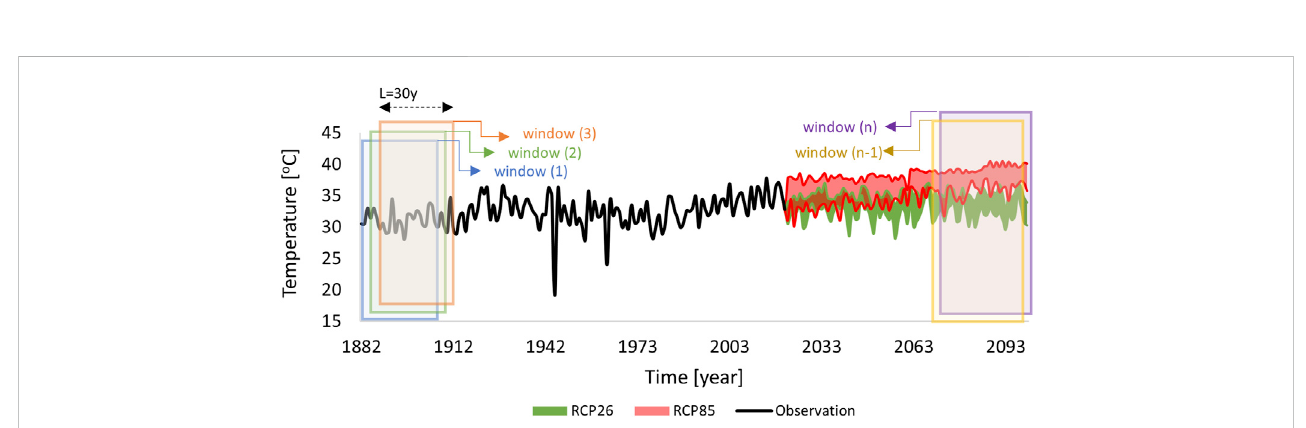
FIGURE 3 Multi-model envelope of the bias-corrected climate model projections for the maximum temperature ( T max ). The quasi-stationary windows, each 30 years long are shown by bounding boxes.